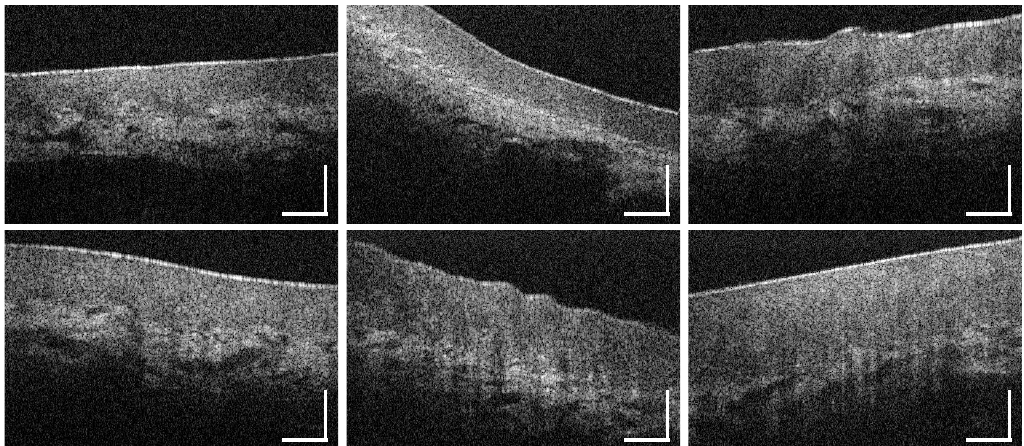
Figure A14. Supplementary intensity-based OCT cross sections of the mucosal tissue of the lateral inner lower lip (MP4, Figure 1). Scale bars: 200 µ m.